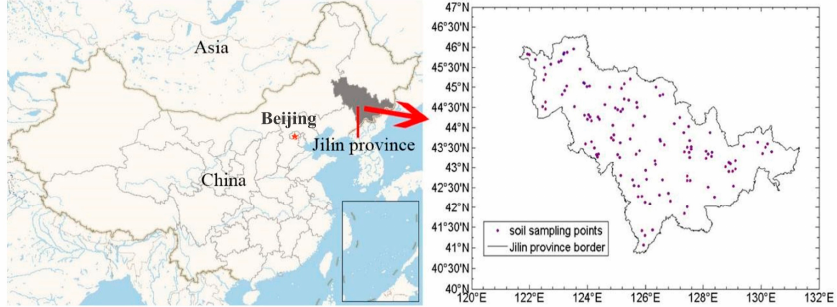
Figure 1. Location of study area and soil sample sampling locations.